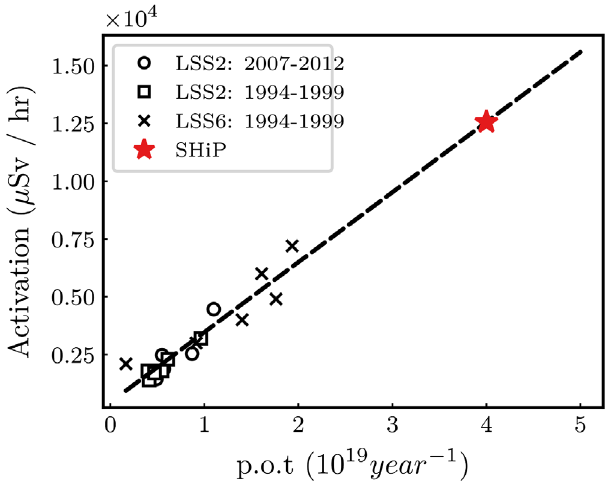
FIG. 1. End-of-run induced radioactivity measured ∼ 30 h after shutdown at ∼ 1 m from the beam line over recent years: peak dose rate at electrostatic septum plotted in LSS2 and LSS6. The extrapolation represents the expected activation level for the SHiP scenario should no improvements to the extraction efficiency be implemented.